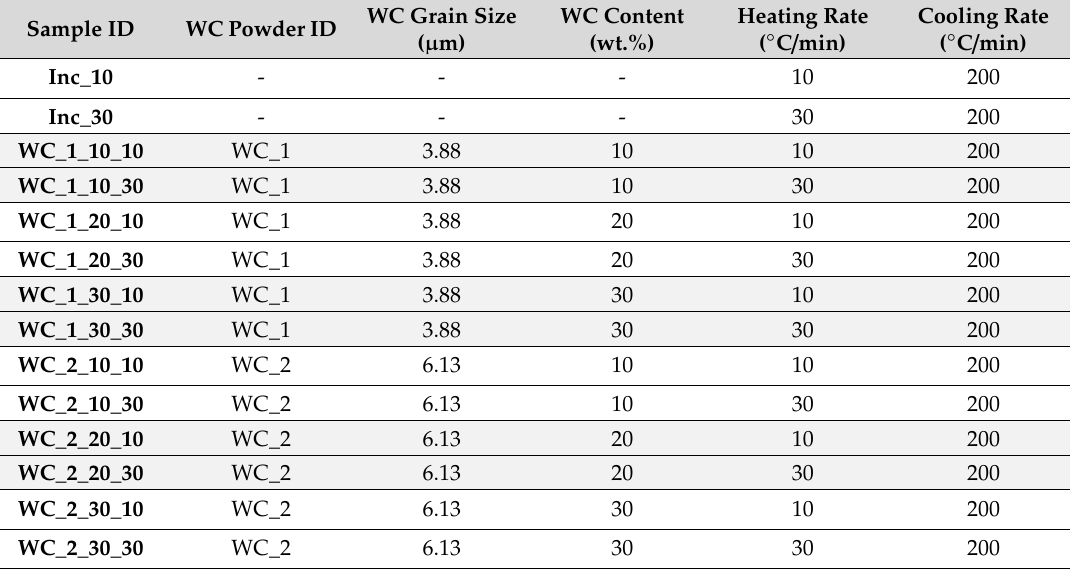
Table 3. List of samples subjected to di ff erential thermal analysis (DTA) with analysis